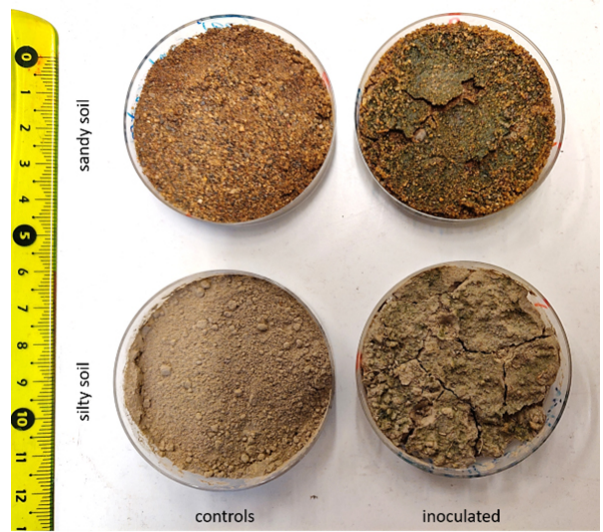
Figure 2. Schizothrix delicatissima AMPL0116 biocrusts induced on sandy soil and silty soil microcosms, inoculated and incubated according to Mugnai et al. (2018a). The strain is not motile and biocrust development is mainly superficial, especially on sandy soil. Picture by Alessandra Adessi and Federico Rossi at DAGRI, Uni- versity of